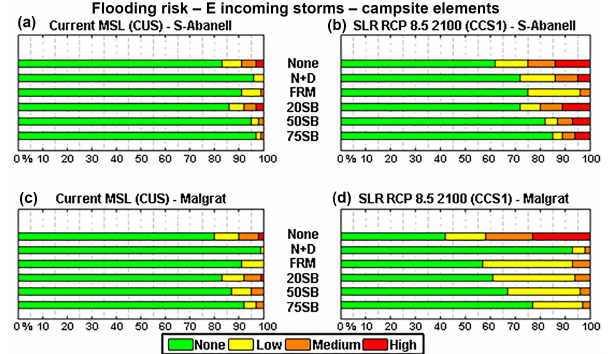
Figure 11. Distribution of campsite elements at every level of flood- ing risk: (a) current scenario at S’Abanell; (b) climate change sce- nario 1 (SLR) at S’Abanell; (c) current scenario at Malgrat; (d) cli- mate change scenario 1 (SLR) at Malgrat. Each bar in a panel rep- resents a risk reduction configuration (“none”: no measure imple- mented; “N + D”: nourishment and dune; “FRM”: flood resilience measures; “20SB, 50SB, and 75SB”: 20, 50, and 75m setbacks, re- spectively).